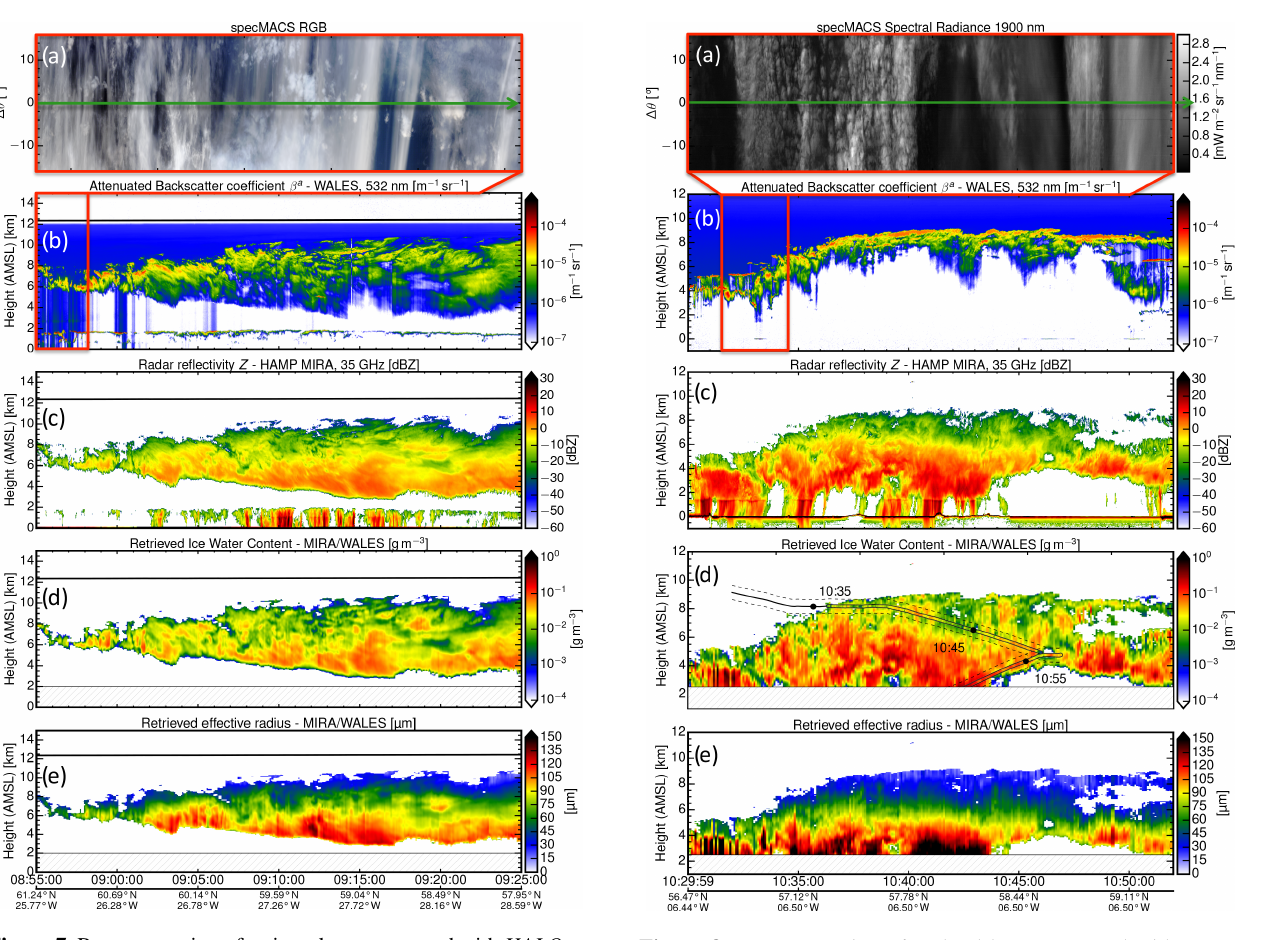
Figure 8. Remote sensing of a cloud layer measured with HALO on 14 October 2016 during the NAWDEX campaign. (a) Spectral radiance at 1 . 9µm acquired by specMACS along the flight path, (b) and (c) same as Fig. 7. (d) Ice water content and (e) effective radius retrieved by VarCloud. As an overlay in panel (d) , in-situ- measured IWCs are plotted along the BAa-146 flight path (drawn line) with the spatial region (dashed lines) considered for the in situ comparison in Fig.